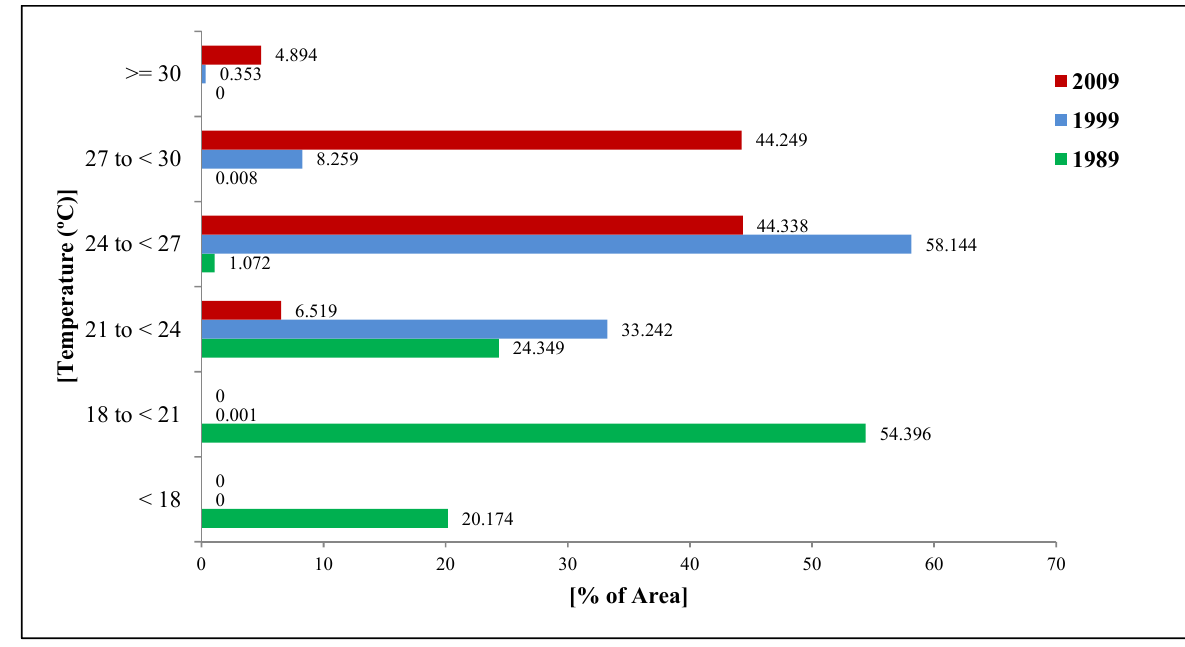
Figure 9. Changing pattern of heat zones in DMP